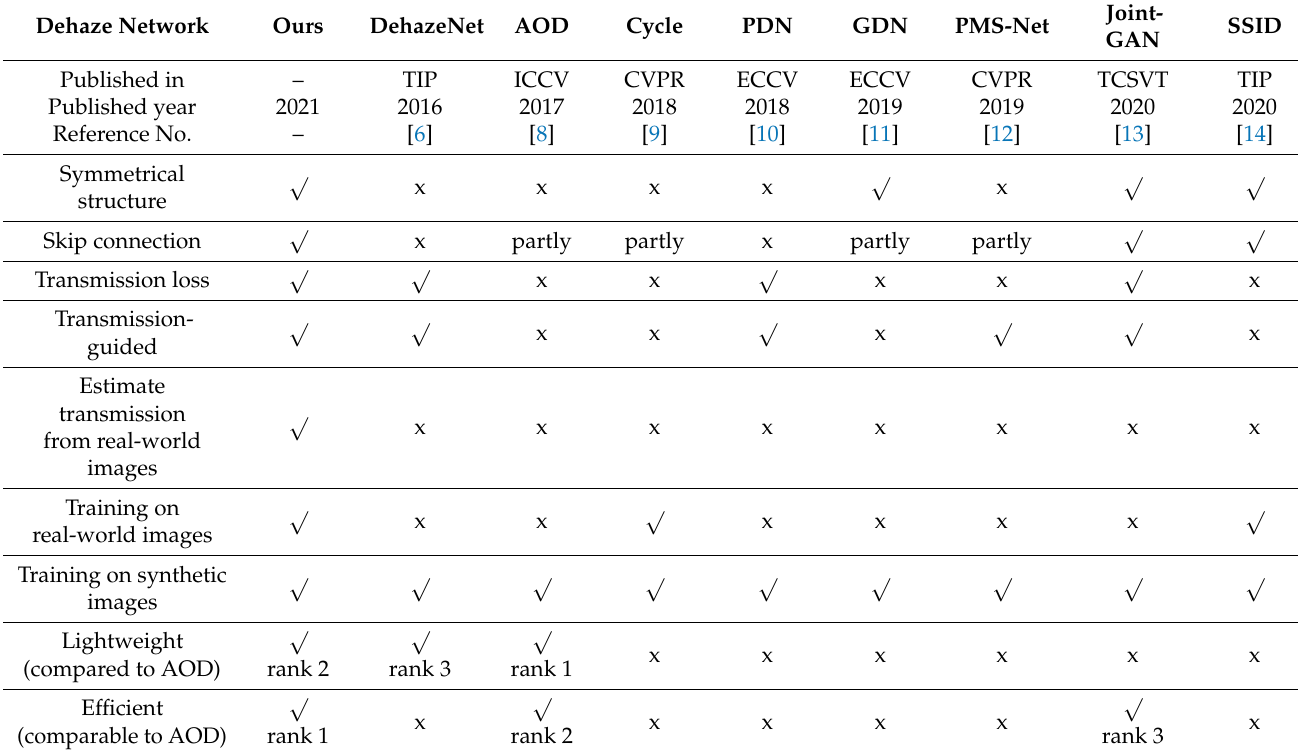
Table 1. Summary of differences from previous dehazing